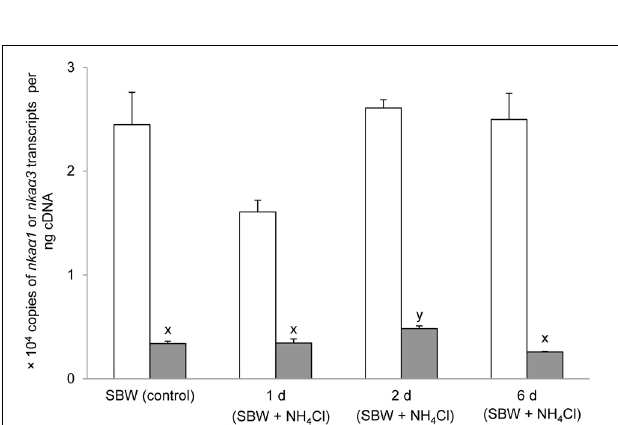
amino acid residues are indicated by shaded black residues and similar amino acids (threshold value 60%) are indicated by shaded gray residues. Vertical boxes represent coordinating residues for Na + or K + binding. Asterisks indicate the amino acid residue that is similar to Nka α 1c but different from Nka α 1a and Nka α 1b.